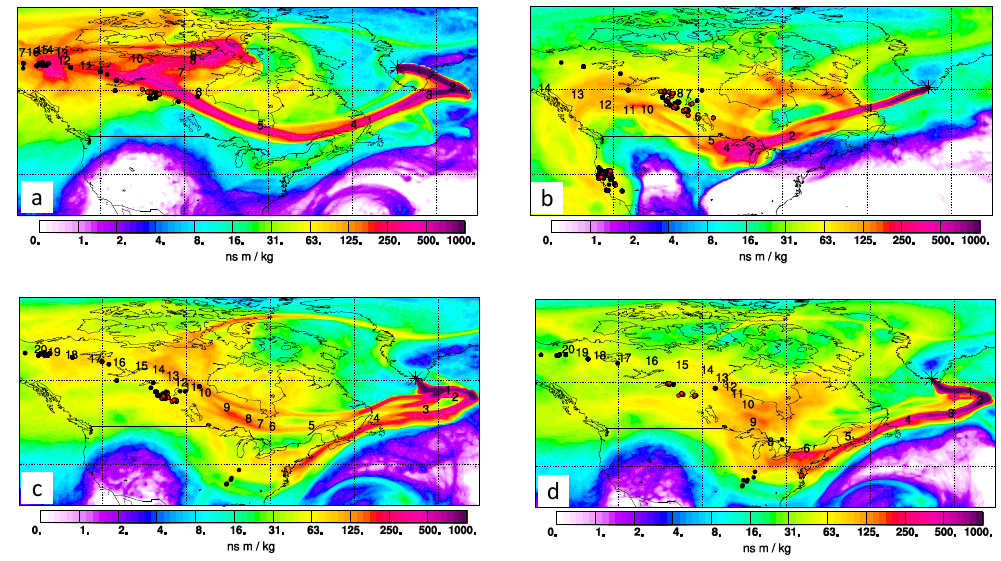
Fig. 5. Column-integrated emission sensitivity on 8 July 2008 for Plume I to III. (a) Plume I, 13:27:45–13:31:47 UTC, shows BB contri- butions from Canada. (b) Plume II, 14:56:03–15:01:40 UTC, shows FF influence from the Great Lakes area and BB contributions from Canada and the US West Coast. (c) Plume III, 15:39:35–15:44:16 UTC, presents BB influence from Canada and FF contribution from the Ohio Valley and US East Coast. (d) Plume III, 15:46:08–15:46:43 UTC, shows contributions of FF from the Ohio Valley, Great Lakes area and the US East Coast and some BB influence from